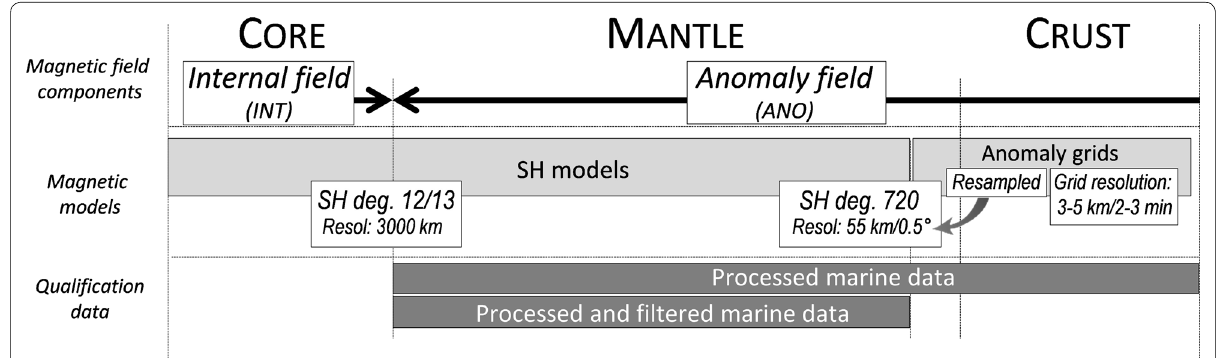
Fig. 1 Summary diagram illustrating the definition of the magnetic components of the Earth’s magnetic field used in the study, the associated geomagnetic models and the data used for evaluation, according to SH degrees and spatial